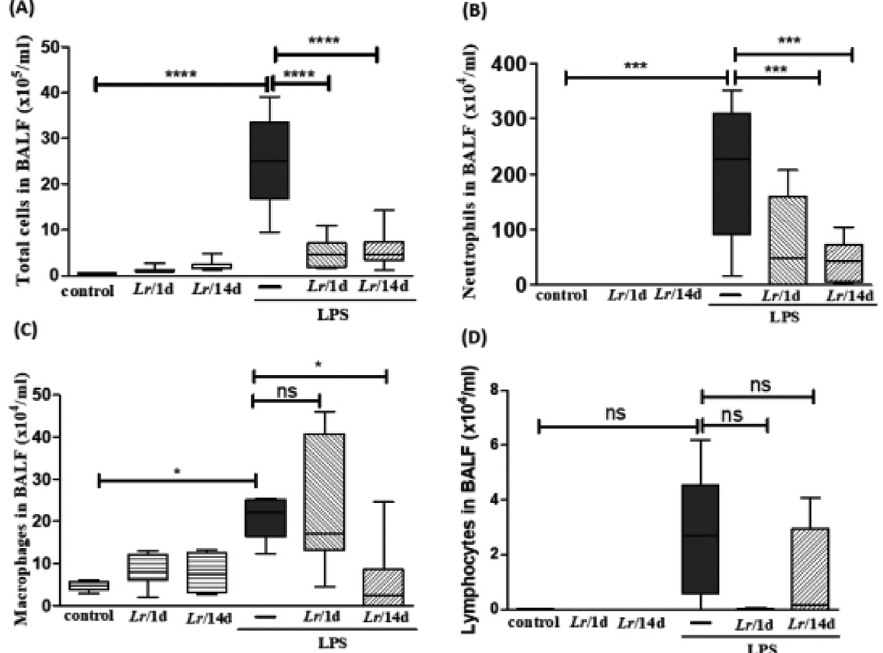
Fig. 2. Total and differential of in fl ammatory cells in BALF. The C57Bl/6 mice were treated with Lacticaseibacillus rhamnosus (10 9 CFU Lr in 300 µ L of PBS, orogastric by gavage) for 14 days or one day, before the instillation of E. coli LPS (0.5 mg/Kg, intranasal). The mice were euthanized 24 h after the LPS, and the BALF was proc- essed according to Materials and Methods. Total cells (2A); neutrophils (2B); Macrophages (2C); lymphocytes (2D). The results are expressed as mean ± SEM **** p < 0.0001; *** p < 0.001; ** p < 0.01; * p < 0.05 and ns: non-signi fi cant